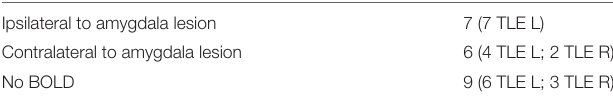
TABLE 2 | BOLD signal in